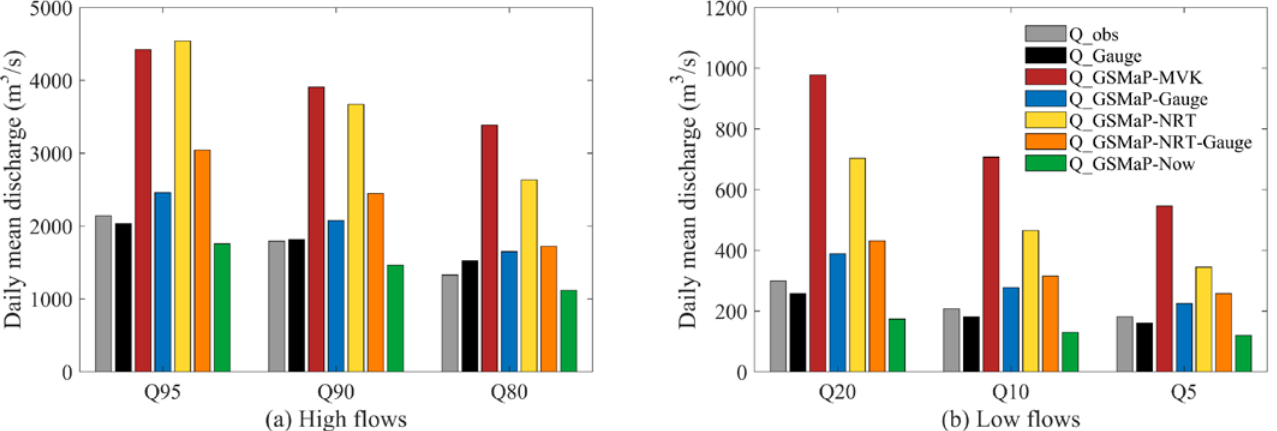
Figure 10. The simulated high and low flows at the Tangnaihai hydrological station using the rain-gauge-based precipitation data and the five GSMaP SPPs in comparison with the observations in the period of 29 March 2017–31 December 2018 (Q95, Q90, Q80, Q20, Q10, and Q5 denote the 95%, 90%, 80%, 20%, 10%, and 5% daily discharge quantiles, respectively).